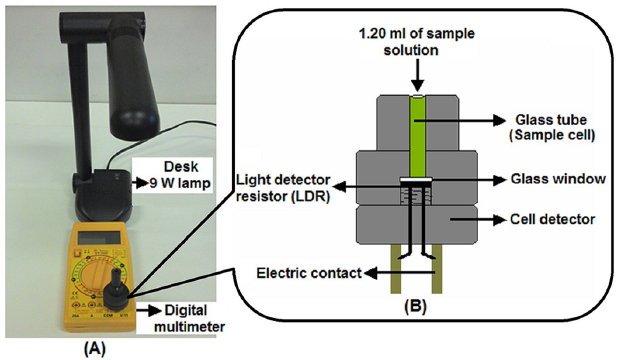
FIGURE 3 - (A) General view of optical device mounted on digital multimeter. ( B ) Schematic diagram of optical